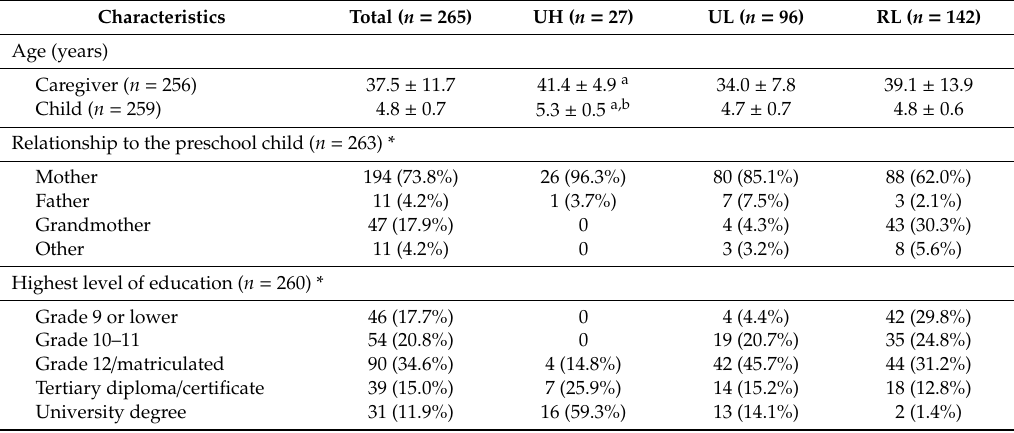
Table 1. Demographic characteristics of parents / caregivers by income